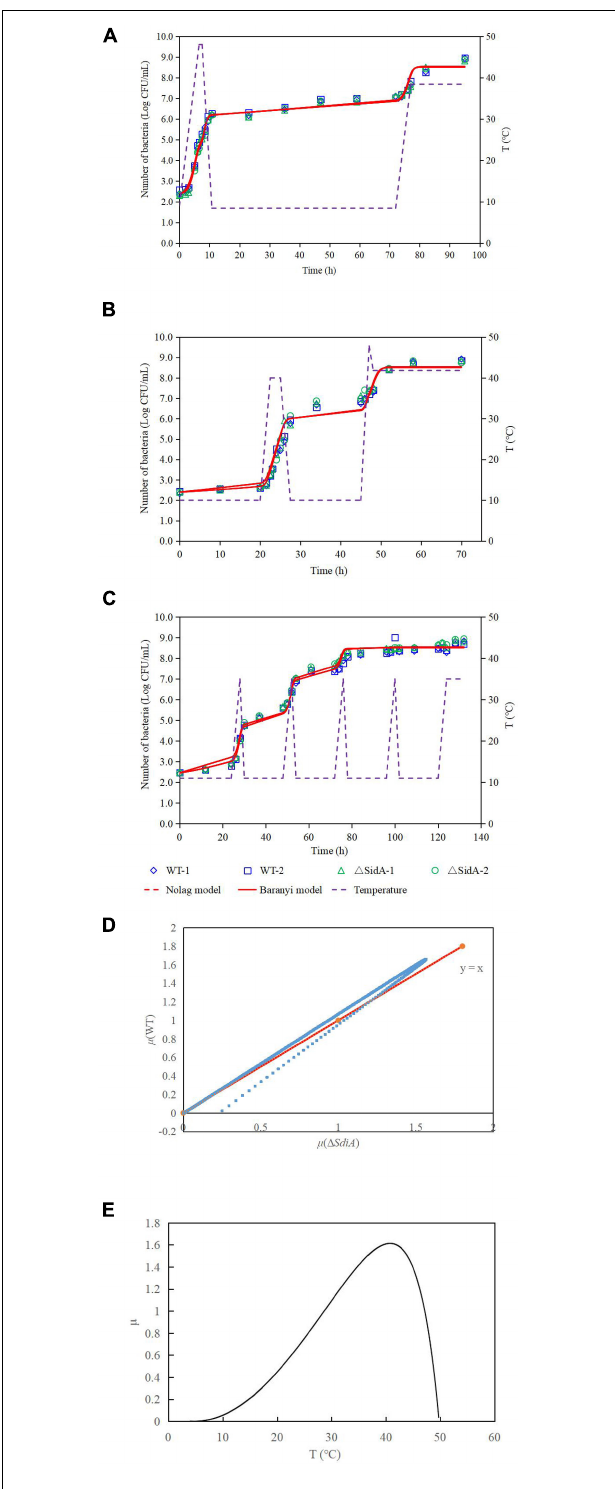
FIGURE 2 | One-step analysis for C. sakazakii wild-type and (cid:49) sdiA mutant strains. (A–C) One-step fitting analysis of the growth curve of C. sakazakii WT and (cid:49) sdiA mutant strains in powdered infant formula recovery. (D) Growth rate distribution of (cid:49) sdiA mutant and WT strains. (E) One-step analysis: Effect of temperature on growth rate of WT and (cid:49) sdiA mutant